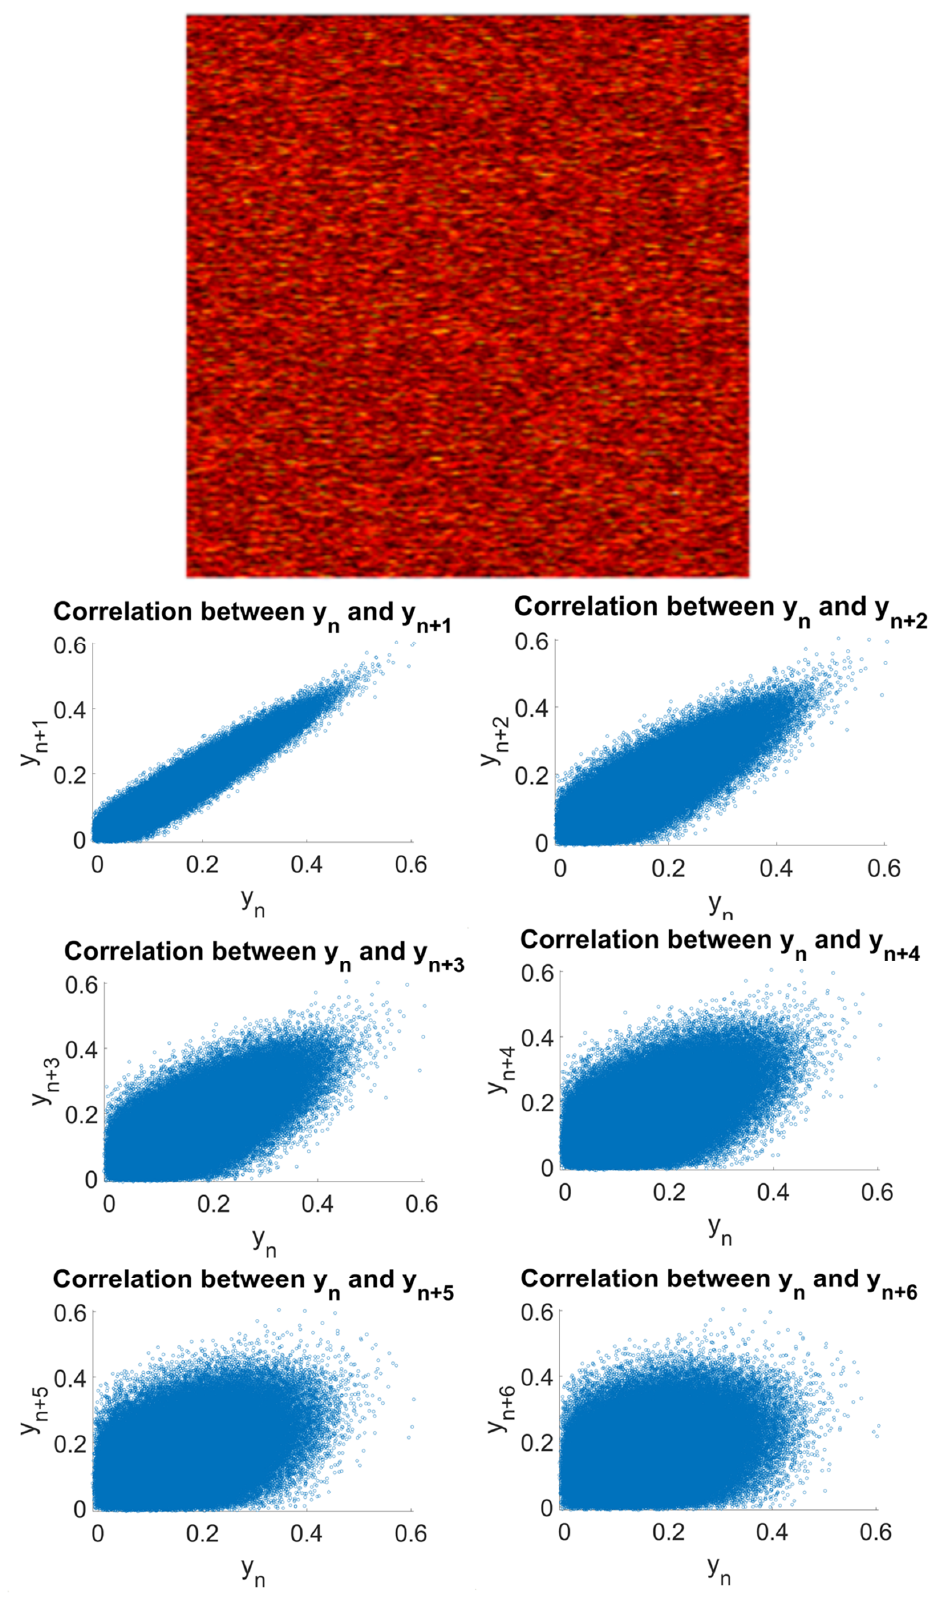
Figure 7. Scatter plots of two pixels along the fast axis. In each plot, y n is the value of a pixel at column n . The image was acquired with an acquisition time of 16